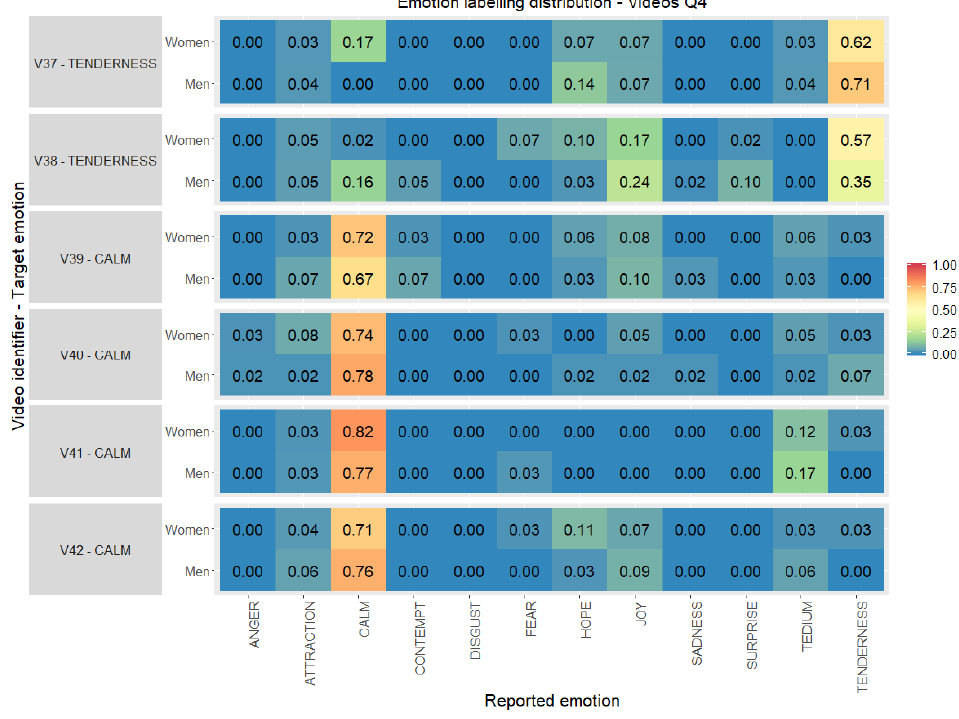
Figure 7. Emotion labelling distribution (0.00–1.00) between the emotions reported by the volunteers with respect to the original target per video clip selected, gender and quadrant 4 (percentage computed considering individually women and men totals per stimuli). Table 7. Pearson standardized residual values (Z-factor) between the discrete emotion reported and gender. Joy